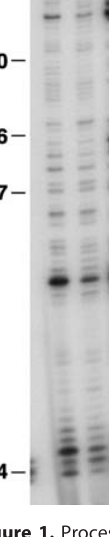
Figure 1. Processivity of Wild-Type HIV-1 and HIV-2 RTs As described in Materials and Methods, a 5 9 end-labeled primer was annealed to single-strand M13mp18 DNA, then extended with wild-type HIV-1 RT or HIV-2 RT in the presence of 10.0 l M of each dNTP and unlabeled poly(rC) (cid:1) oligo(dG), which acts as a ‘‘ cold trap. ’’ The cold trap limits extension to one round of polymerization. The location of the size marker bands (in nucleotides) are shown on the left. DOI: 10.1371/journal.ppat.0020010.g001